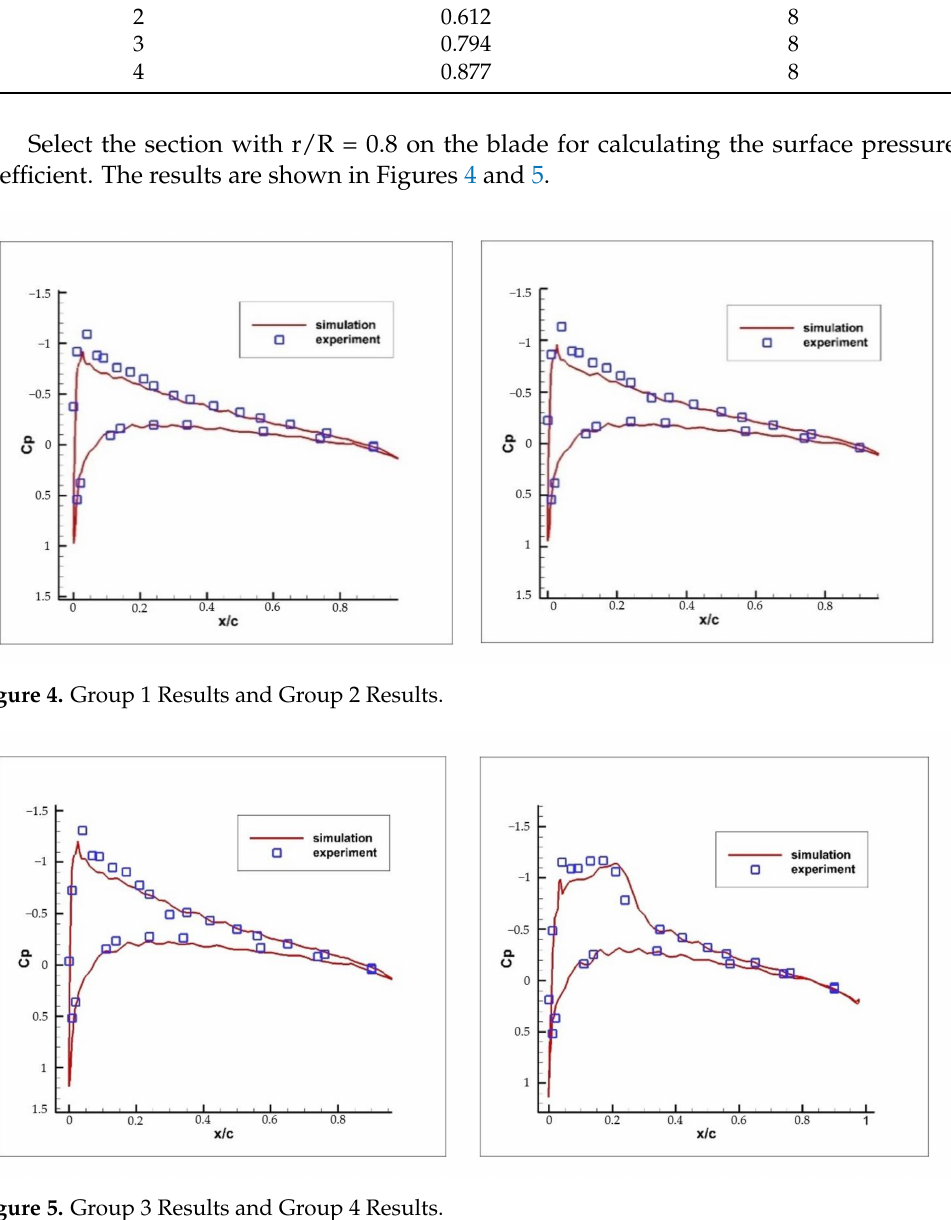
Figure 5. Group 3 Results and Group 4